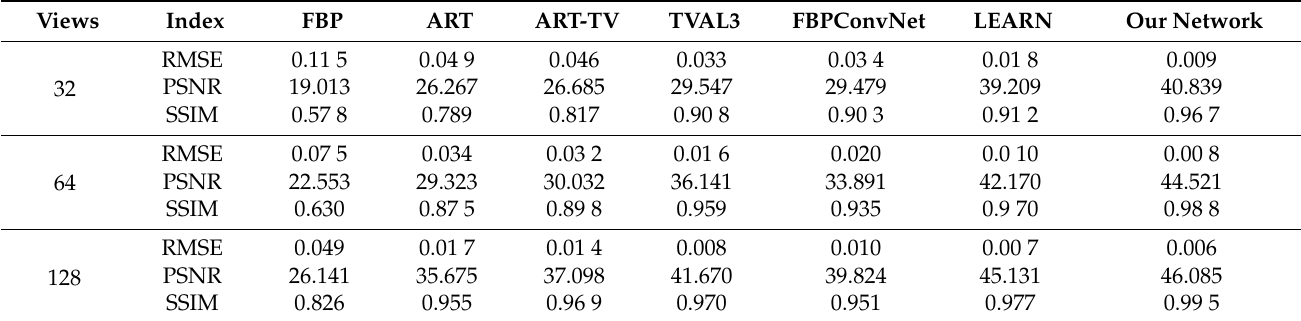
Table 2. Quantitative results obtained for different